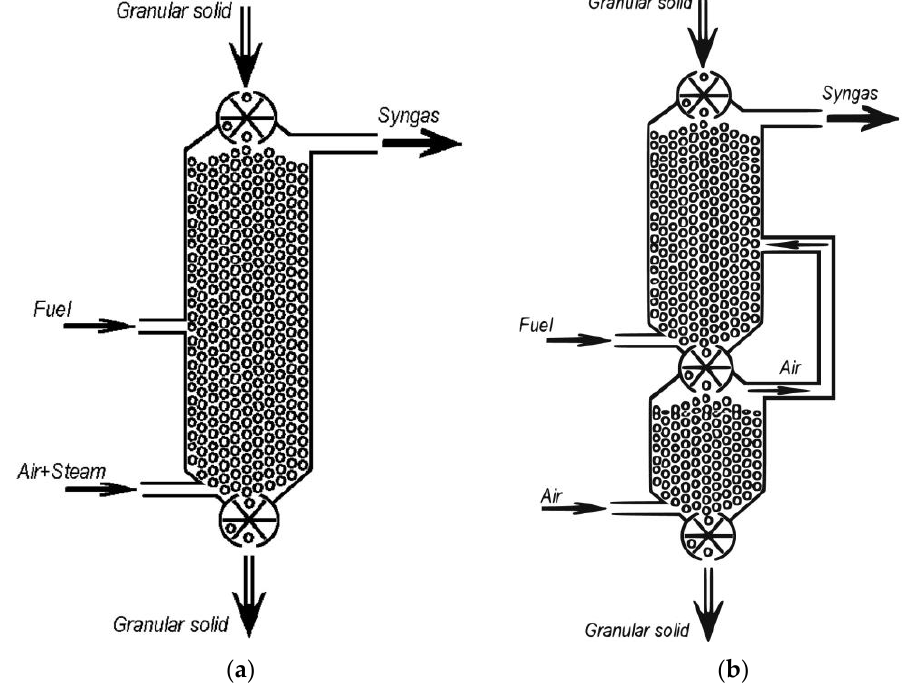
Figure 5. Counterflow filtration combustion reactors with a moving bed of inert coolant: ( a ) without a heat exchanger with lateral fuel inlet [77] (copyright with permission from [77], Elsevier, 2019); ( b ) with a heat exchanger with lateral pre-heated air inlet [78] (copyright with permission from [78], Elsevier, 2019).